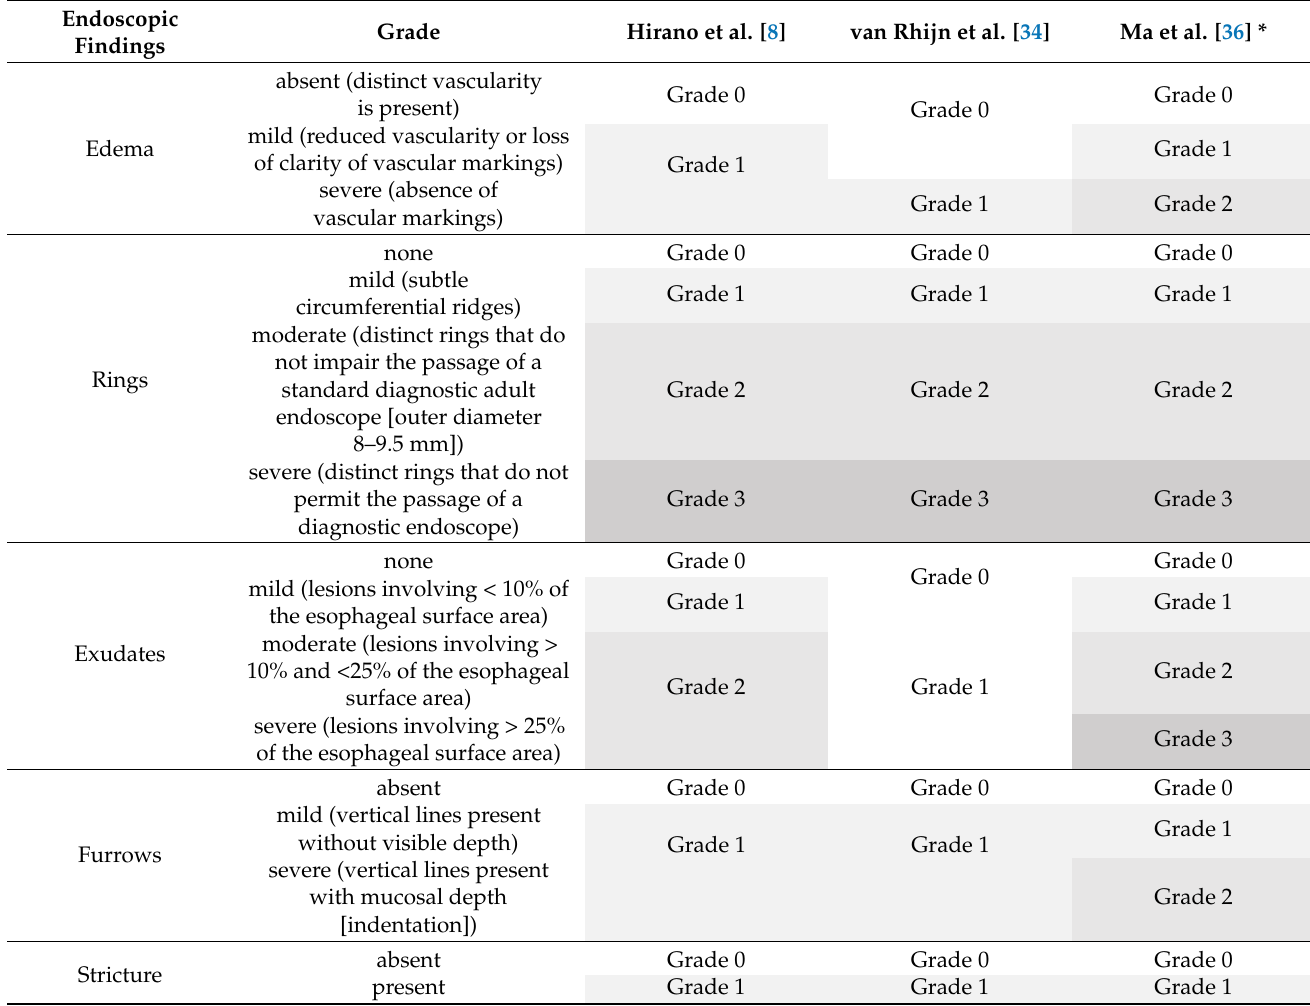
Table 1. The EoE endoscopic reference score